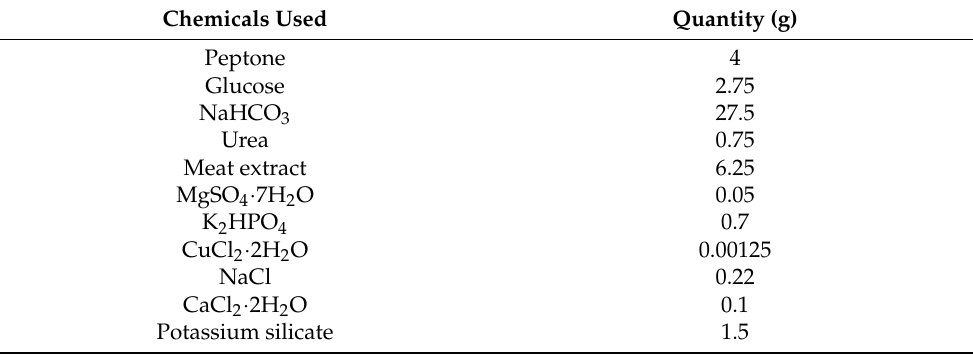
Table 1. Chemicals used and their quantity in the preparation of synthetic